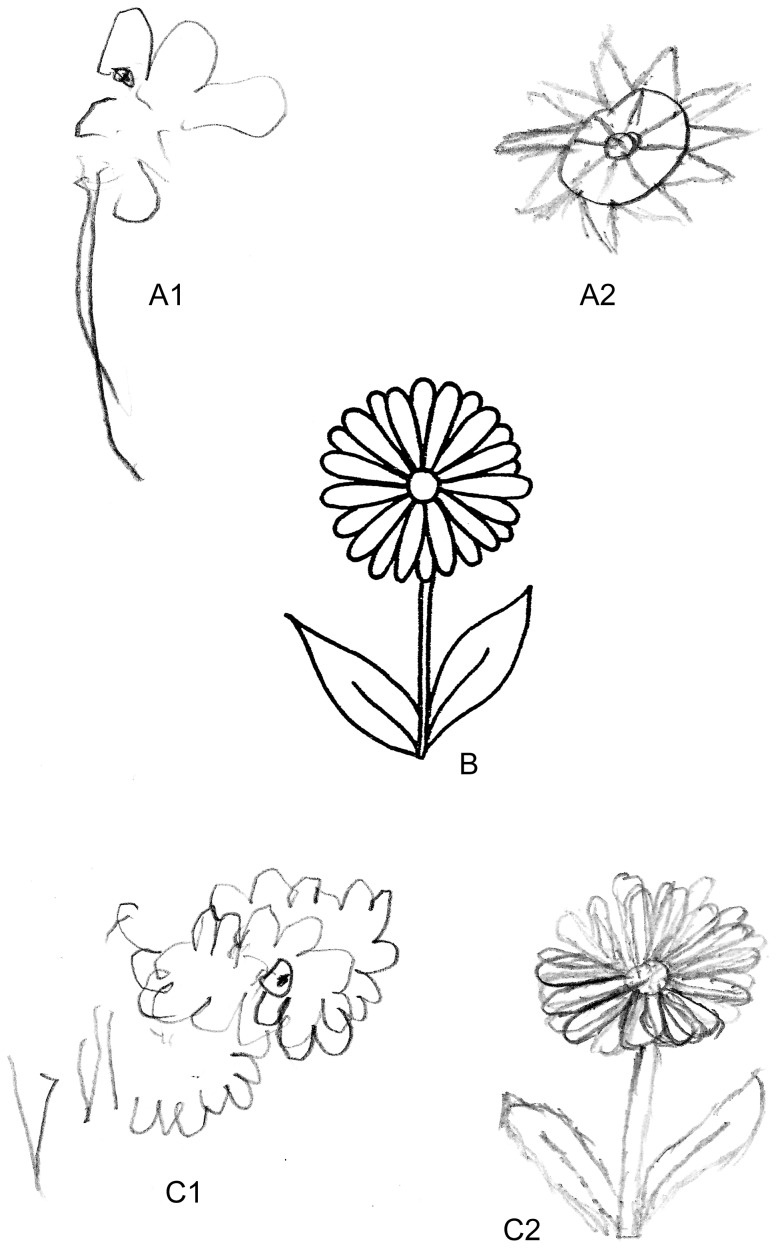
Analysis of visuospatial dysfunction of the patient.Patient's drawings in the context of drawings by a patient with semantic dementia. (SD) scoring 19 in MMSE were presented. A) flowers drawn by the patients from memory: A1) PCA patient, A2) SD patient; B) model, C) patients' copy: C1) PCA patient, C2) SD patient. Copying pictures and drawing to command indicated severe optic ataxia and partial simultanognosia. The test was performed at first neuropsychological assessment. During the second assessment (six months later) the patient was unable to draw even simple patterns and presented with complete simultanognosia.